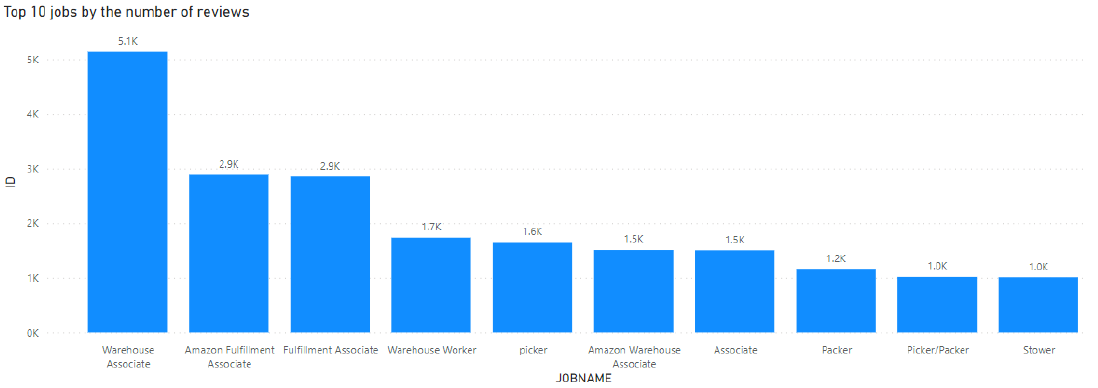
Figure 4. Top 10 jobs distributed based on number of reviews.